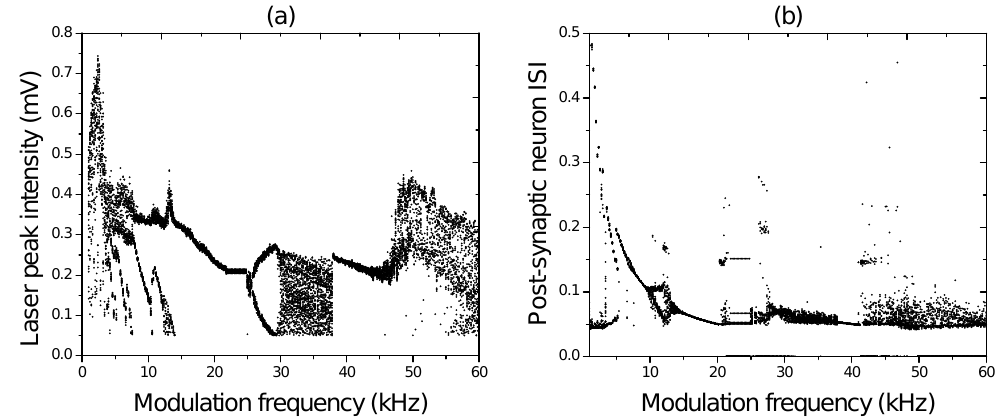
Figure 5. Bifurcation diagrams of ( a ) laser peak intensity and ( b ) post-synaptic neuron inter-spike-interval (ISI) using modulation frequency as a control parameter. A = 1 V, and I = 125